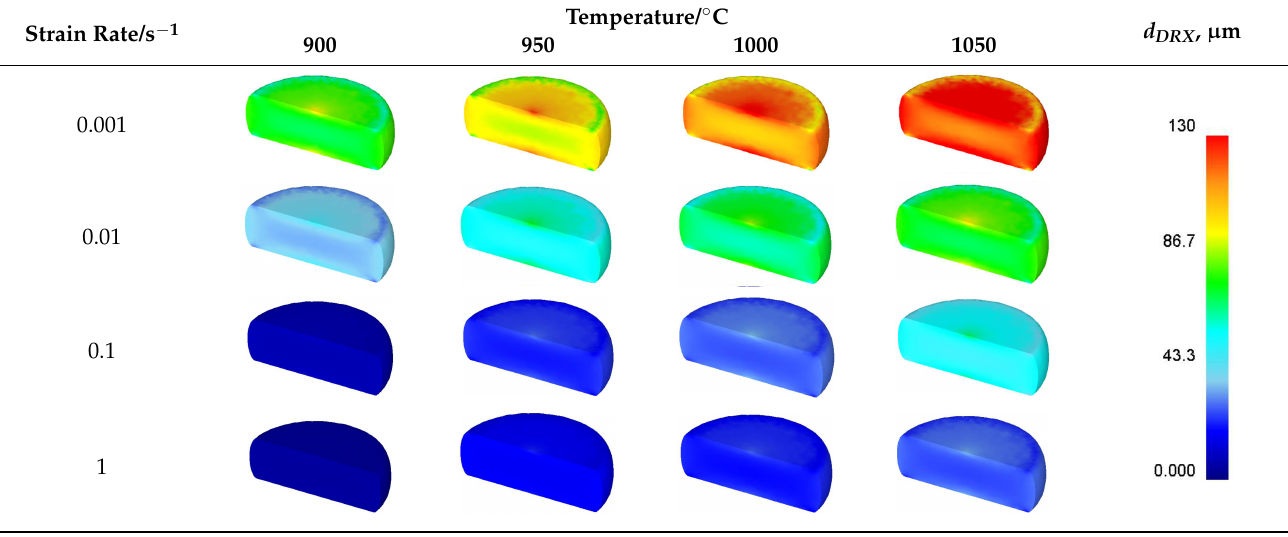
Figure 10. Diagram of deformation area. Table 2. The distribution of d DRX for 47Zr-45Ti-5Al-3V alloys deformed under various hot-working conditions at the true strain of 0.7.